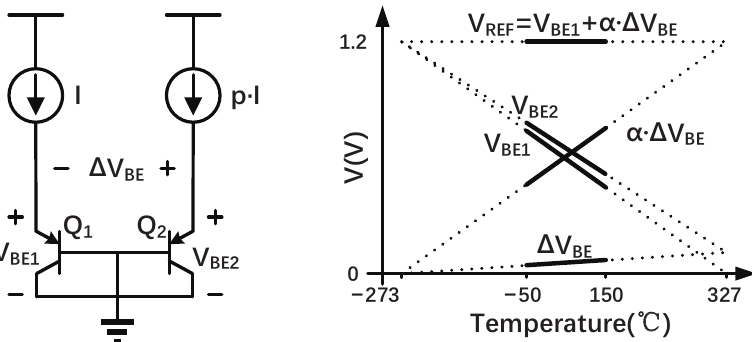
Figure 1. The required voltages generated by two substrate PNPs for temperature measurement.